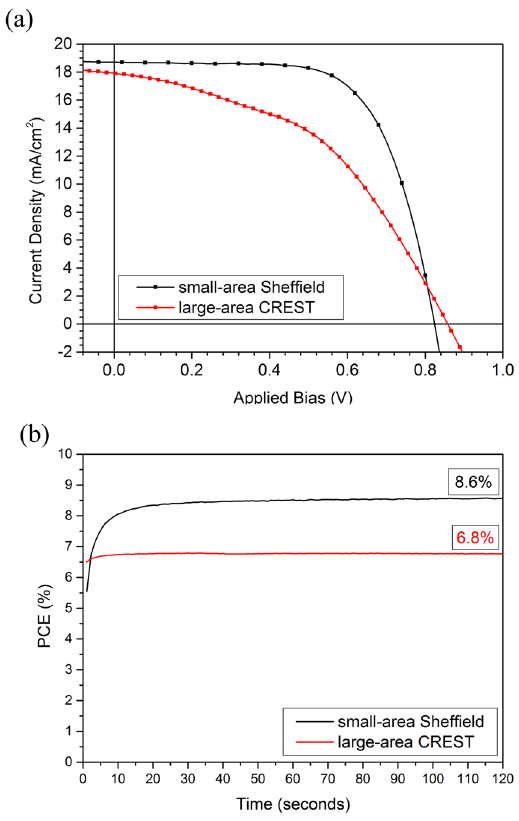
Figure 6. Part ( a ) shows the champion reverse scan JV characteristics for the small-area (measured in Sheffield) and large-area devices (measured at CREST). Part ( b ) shows the stabilised PCE for the champion devices held at a fixed voltage around the maximum power